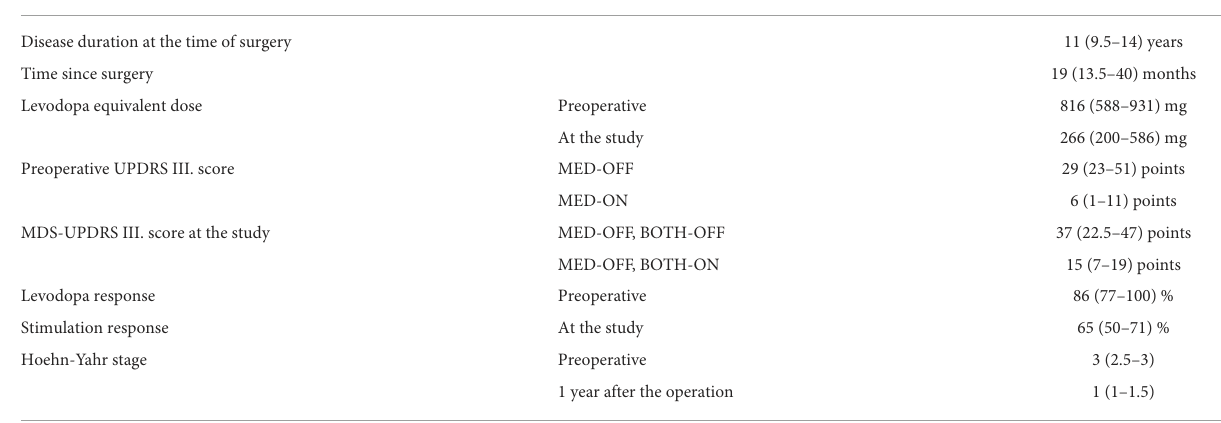
TABLE 1 Demographics and clinical data of the